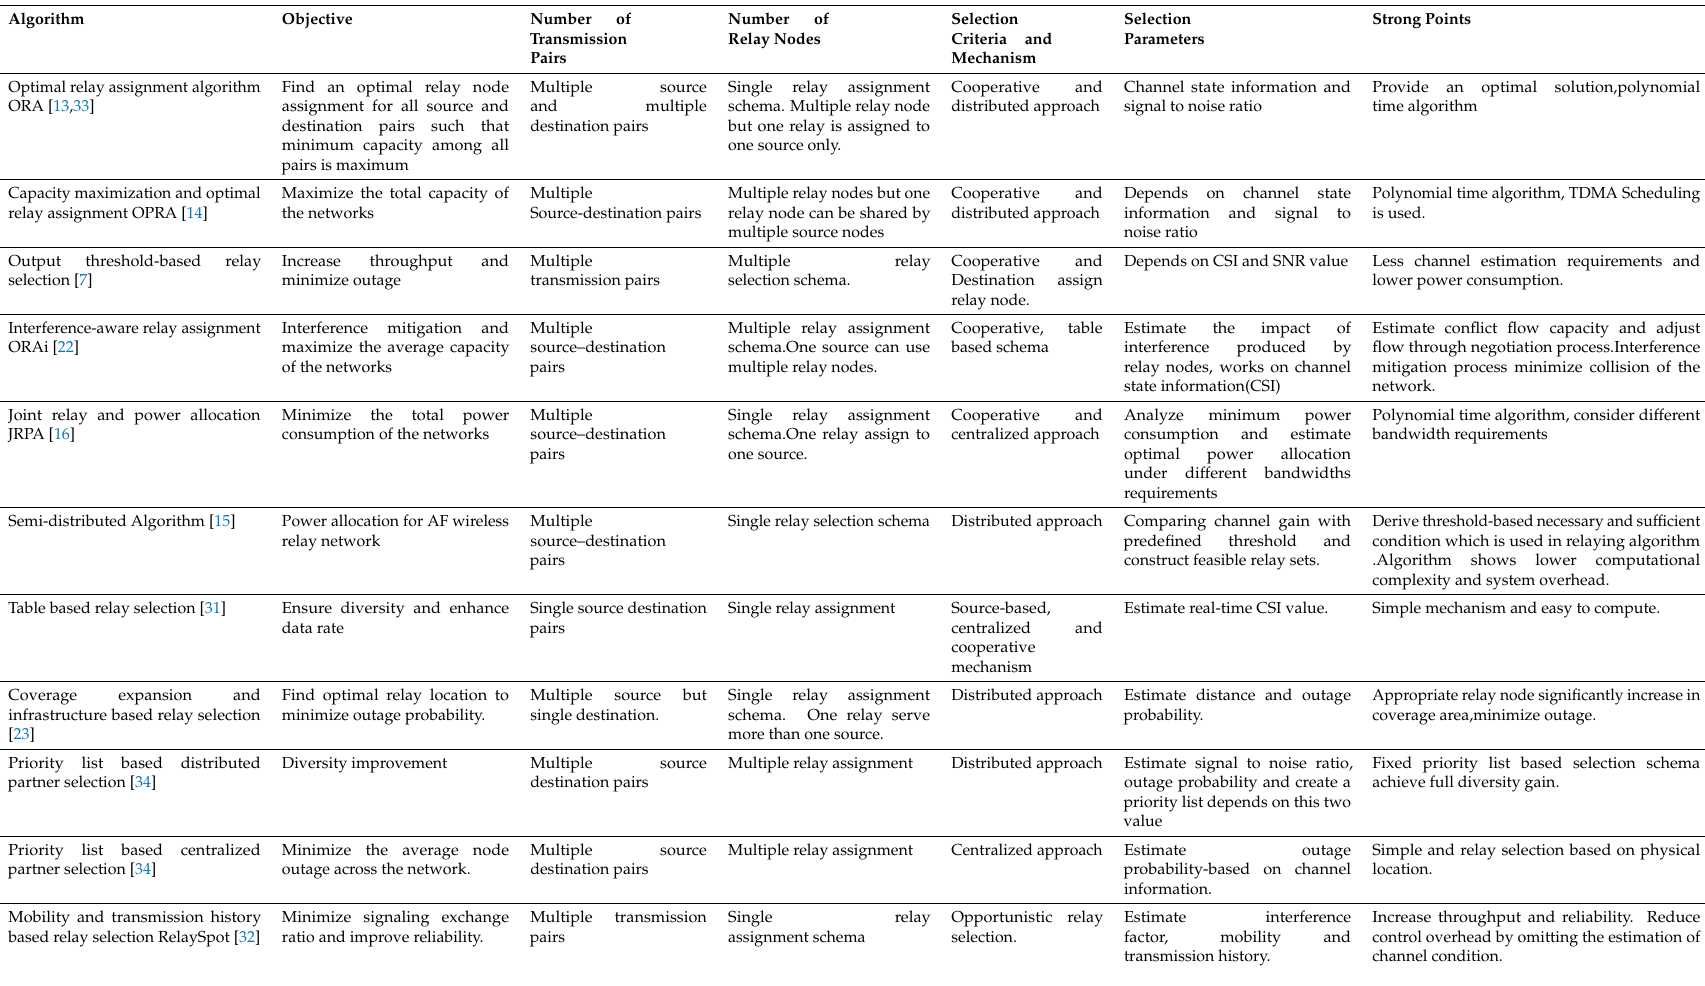
Table 1. Comparison of various relay assignment